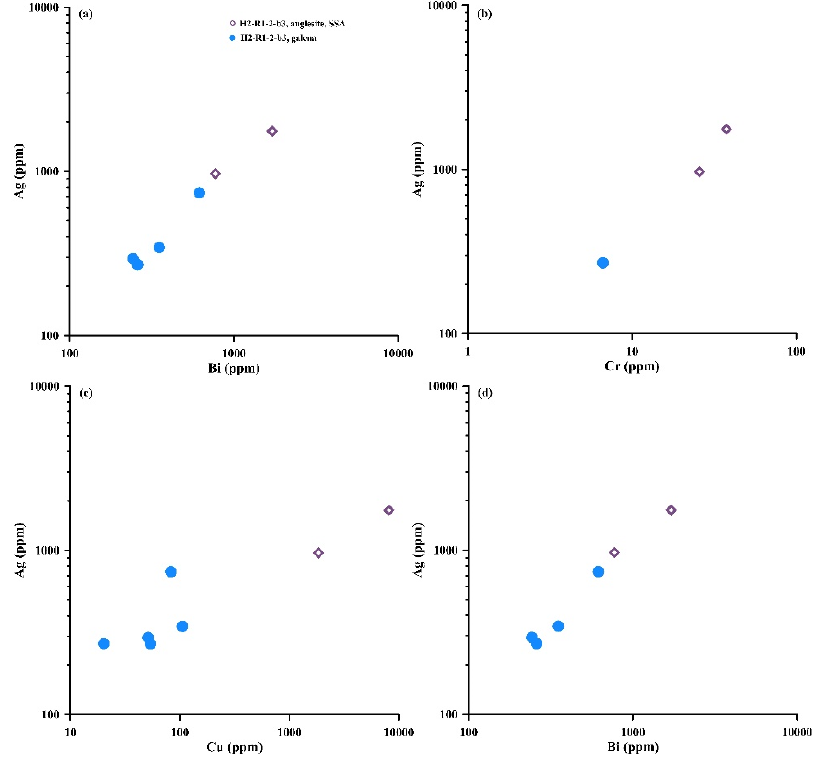
Figure 13. Plots of anglesite and neighboring galena from the MOT hydrothermal field (sample H2-R1- 2-b3): ( a ) Ag vs. Sr; ( b ) Ag vs. Cr; ( c ) Ag vs. Cu; ( d ) Ag vs. Bi. SSA—secondary supergene angle- site.